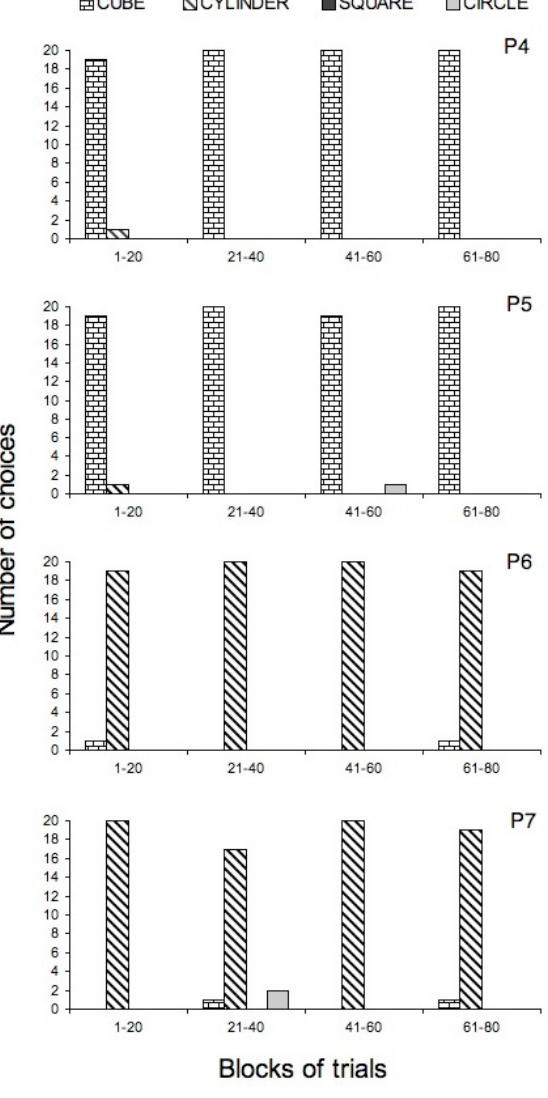
Figure 2. Number of choices of each figure, per block of 20 trials, for each participant. Corrections trials not in-